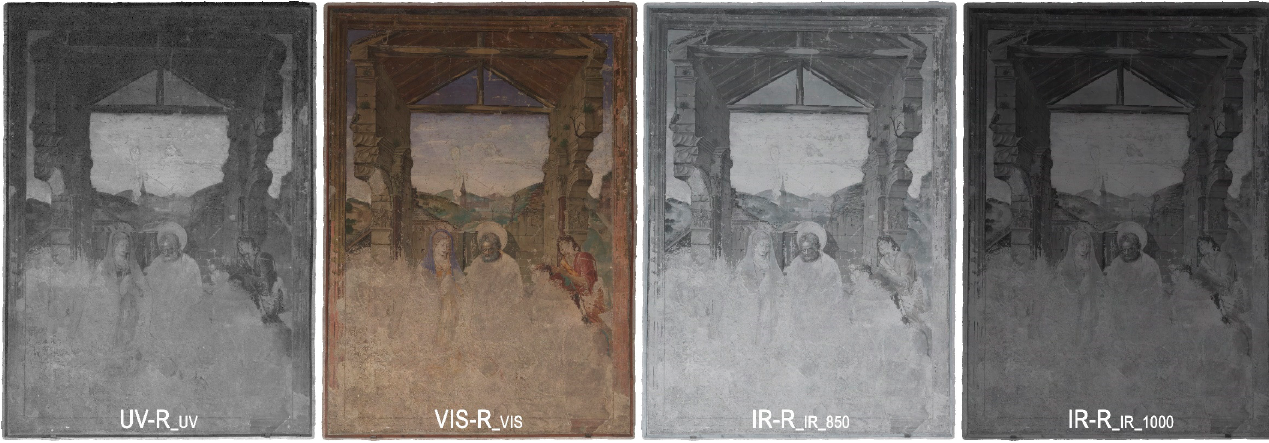
Figure 5. Overview of the MBI